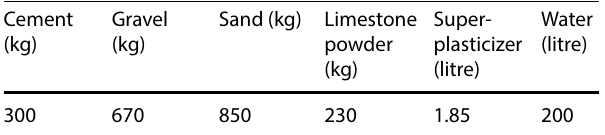
Table 2 Concrete mix ingredients per m 3 Cement (kg)